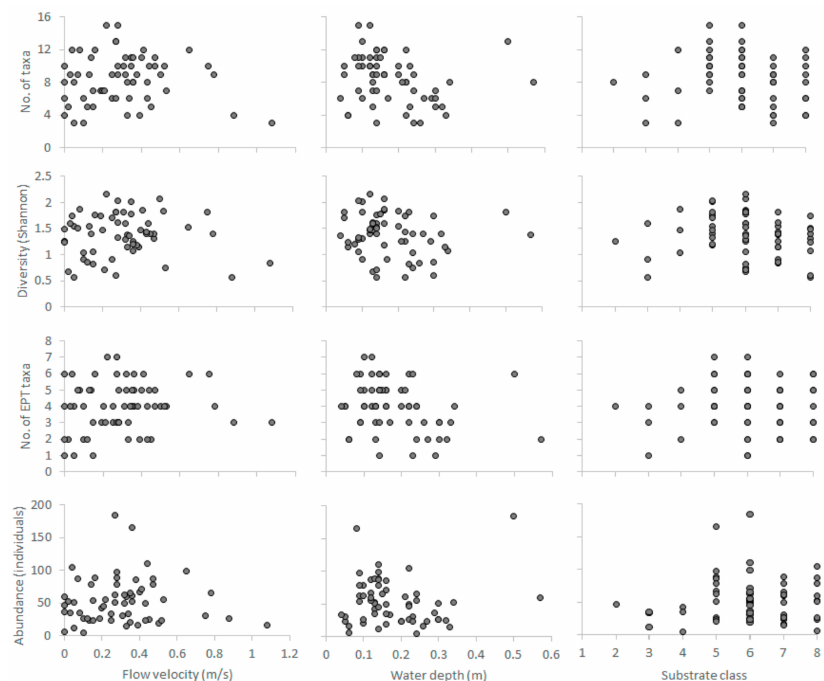
Figure A3. Hydroecological relationships developed from the autumn samples ( n = 60) of the benthos-GR dataset between the three abiotic predictors and the four selected biotic response variables-metrics. Substrate classes; 1: Silt, 2: Sand, 3: Fine gravel, 4: Medium gravel, 5: Large